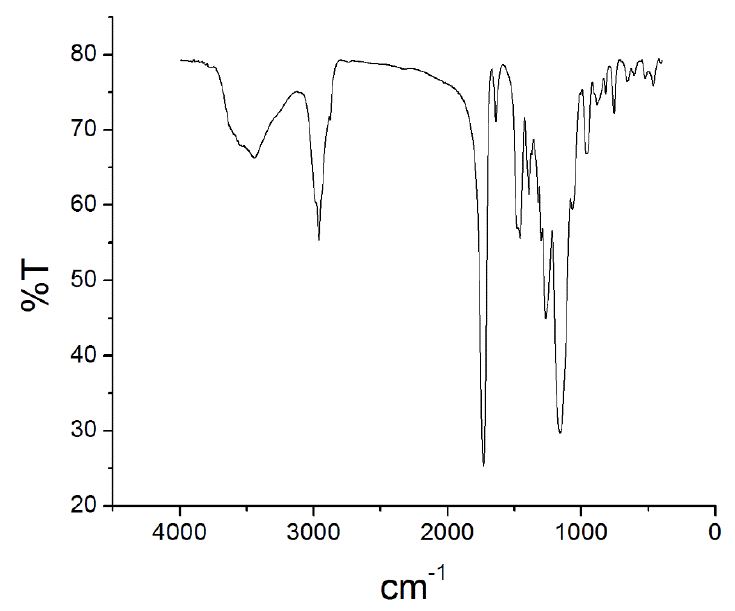
Figure 4. Fourier transform infrared spectrometry spectra of the poly(butyl methacrylate-co- ethyleneglicol dimethacrylate) monolith capillary.